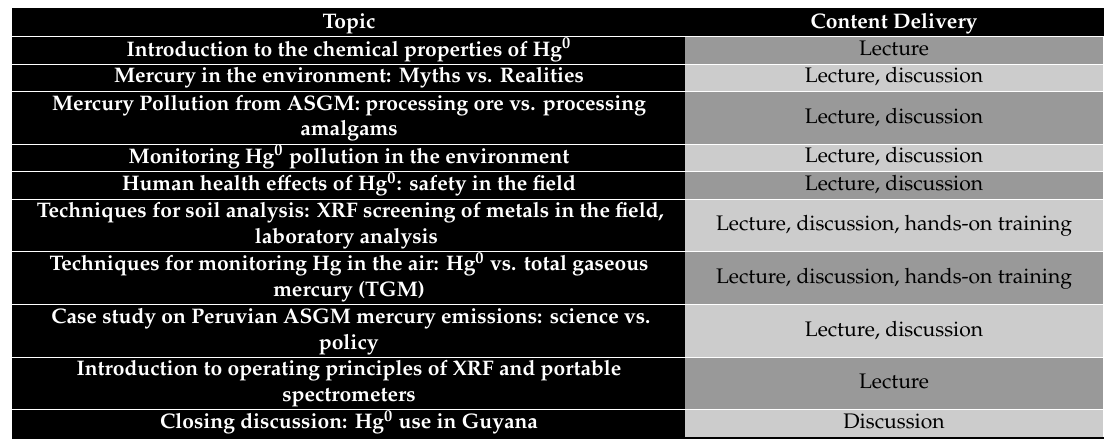
Table 1. Overview of topics covered on day two of the Georgetown